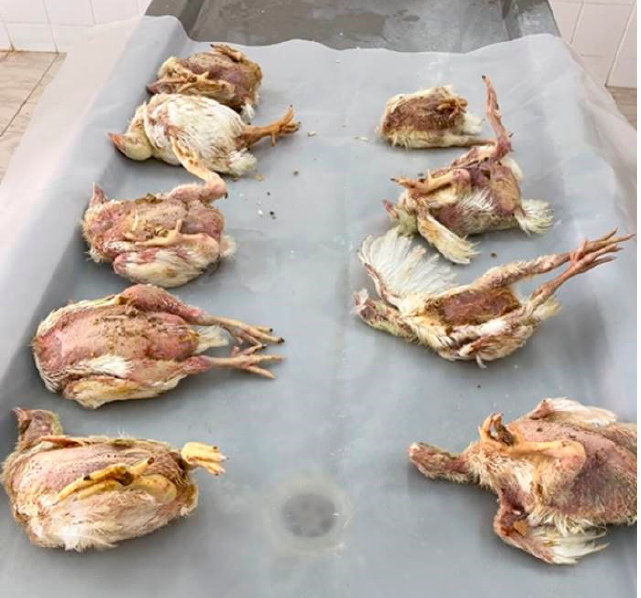
Figure 2. Broiler chicken carcasses infected with FAdV presented for necropsy examination showing rough feather, distended abdomen and diarrhea.